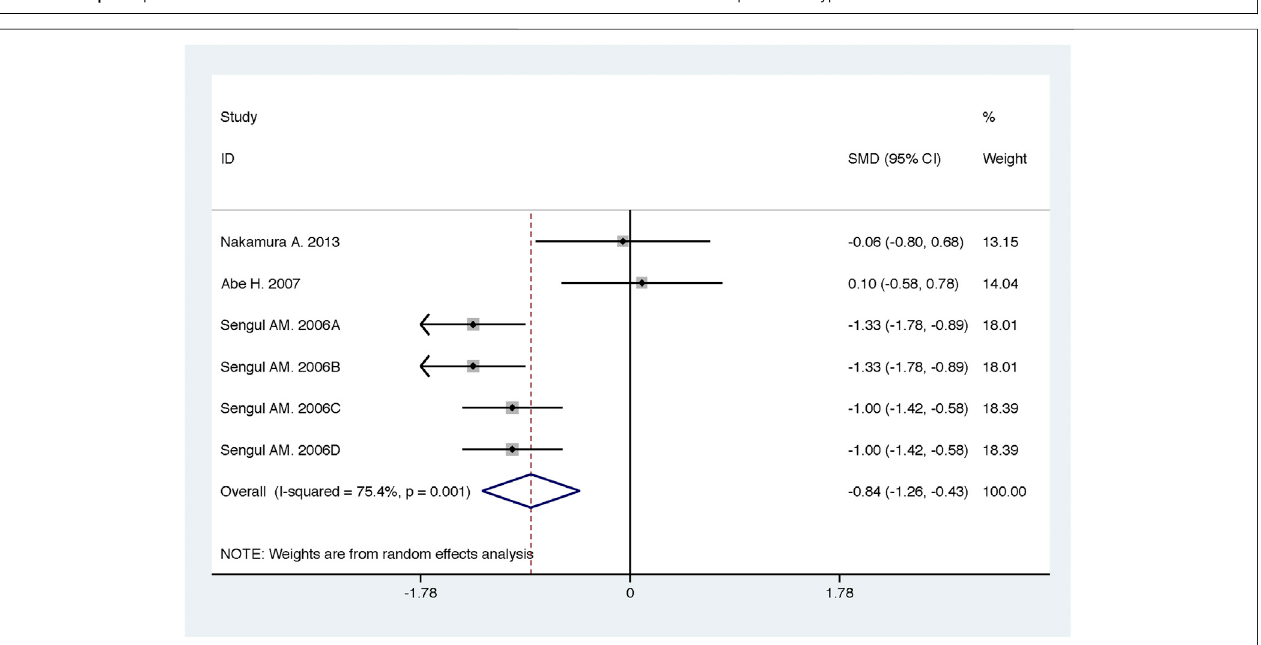
Frontiers in Pharmacology |